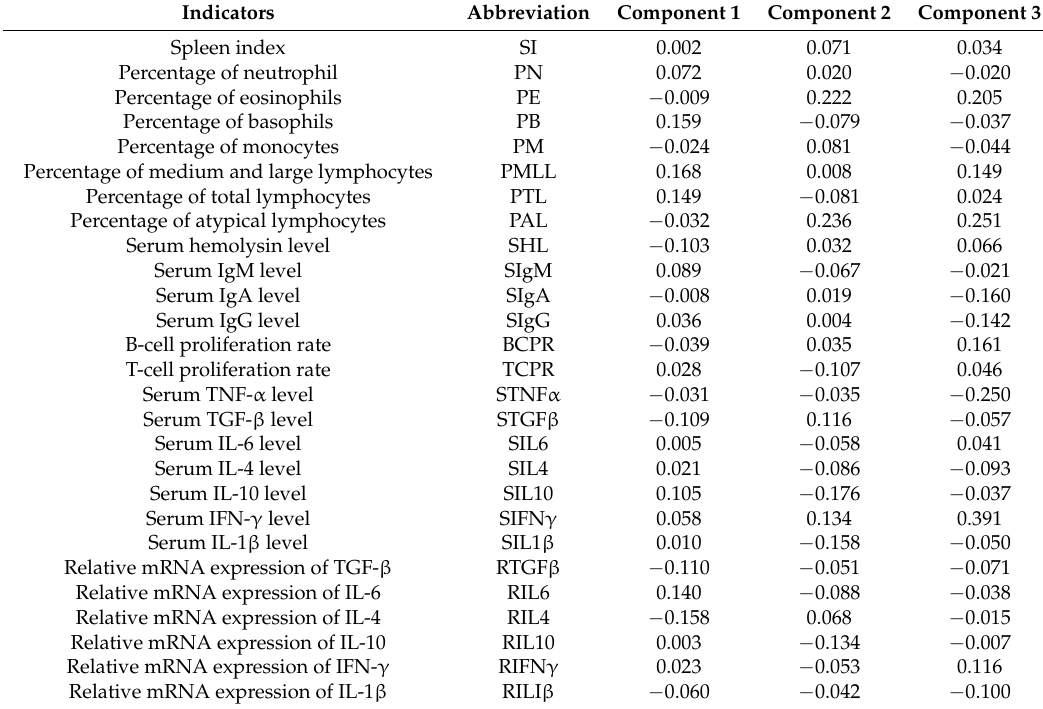
Table 2. The matrix of component